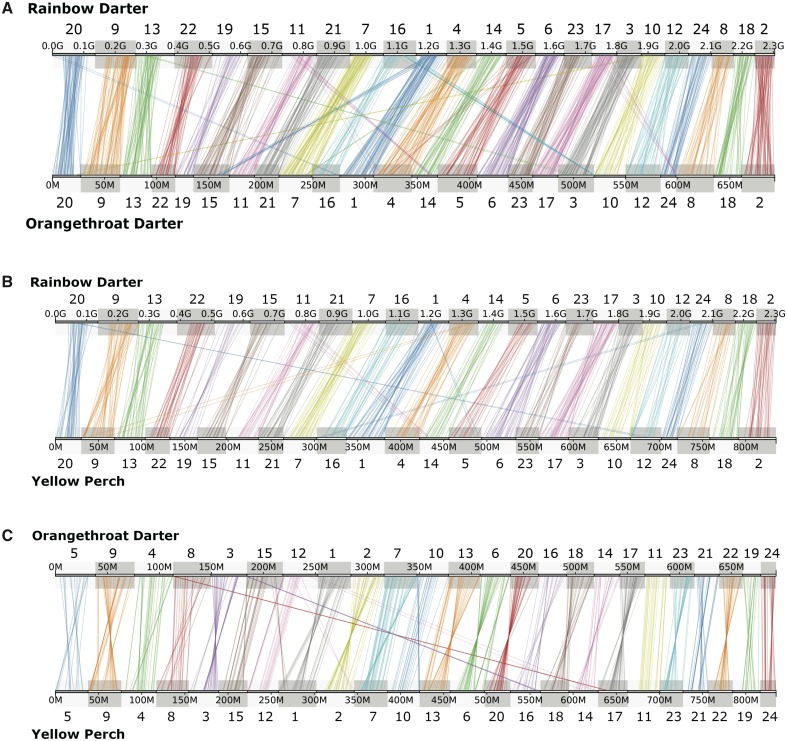
Homology and synteny between linkage groups in the rainbow darter linkage map, orangethroat darter genome assembly, and yellow perch genome assembly. Rainbow darter linkage map markers (i.e., 100 bp RAD tags) were mapped to orangethroat darter (A) and yellow perch (B) genomes. The locations of these markers were also compared between the orangethroat darter and yellow perch genomes (C). Lines represent the alignment position of markers between species pairs, drawn by Synolog using data from reciprocal BLAST searches. Distance along the rainbow darter linkage groups is shown as genetic distance (G) in cM and distance along the orangethroat darter and yellow perch linkage groups is shown in Mb.